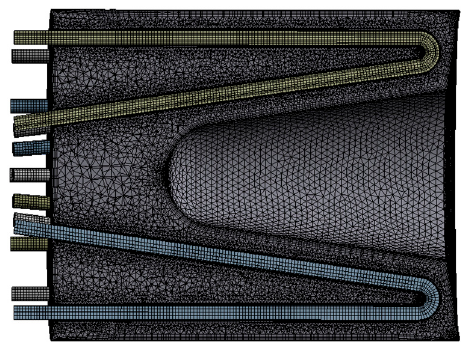
Figure 4. Mesh detail of the receiver cross-section.